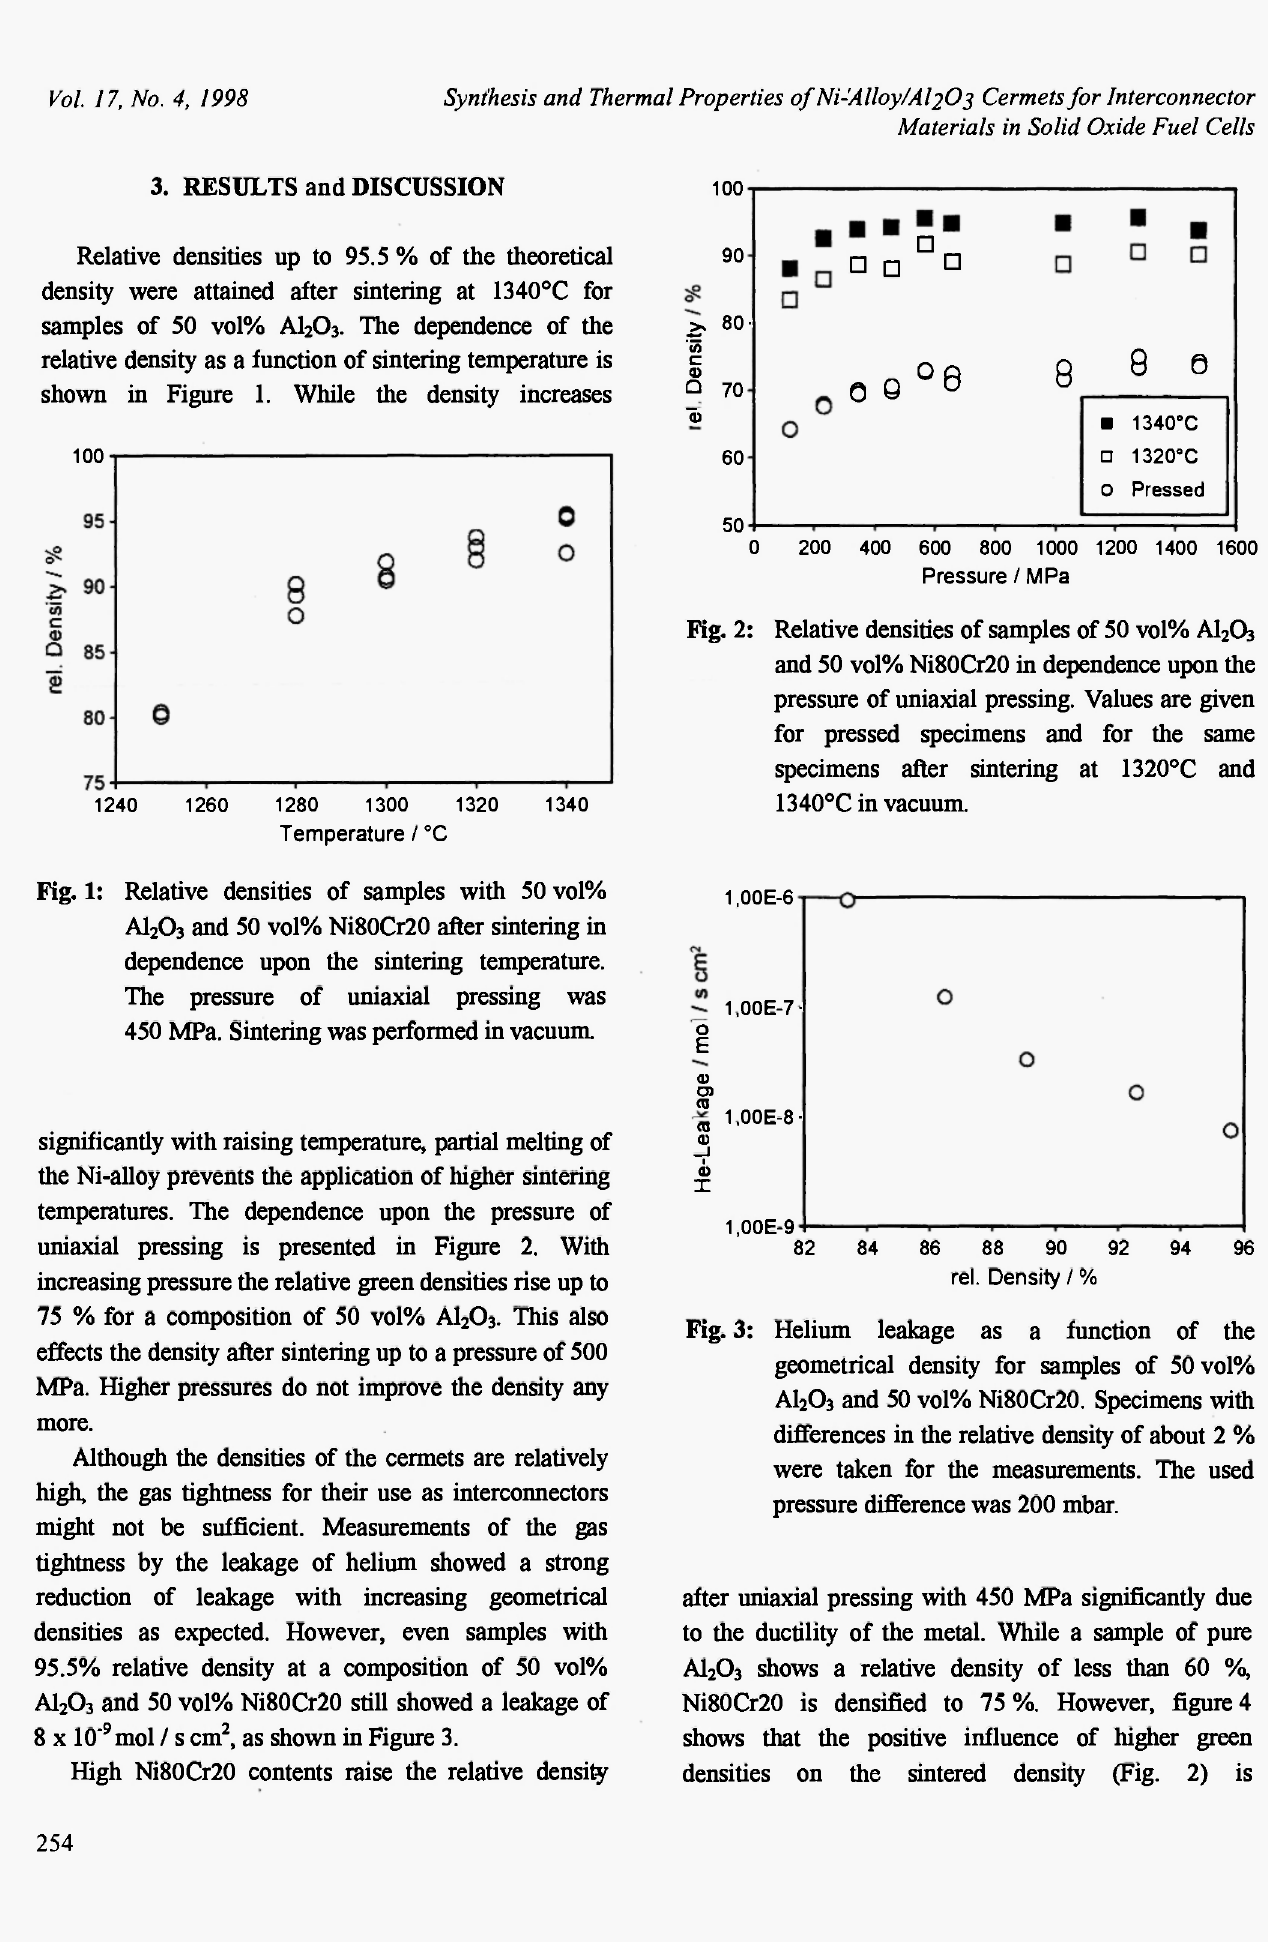
Fig. 2: Relative densities of samples of 50 vol% AI2O3 and 50 vol% Ni80Cr20 in dependence upon the pressure of uniaxial pressing. Values are given for pressed specimens and for the same specimens after sintering at 1320°C and 1340°C in vacuum.